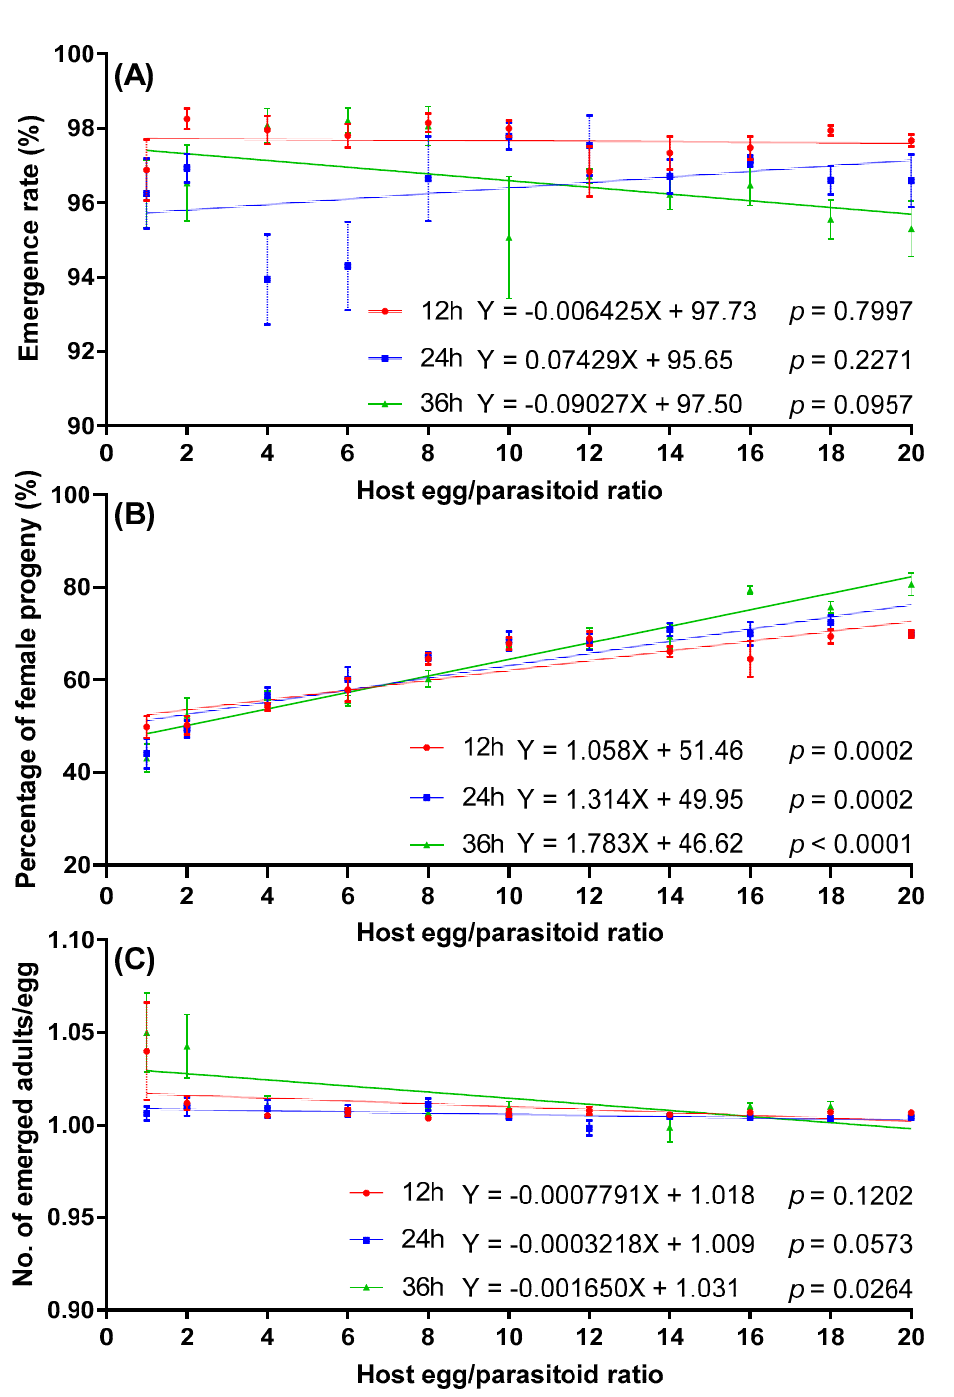
Figure 5. Effect of host egg:parasitoid ratio on emergence rate ( A ), percentage of female progeny ( B ), and number of emerged adults per egg ( C ) of T. remus on S. litura eggs.